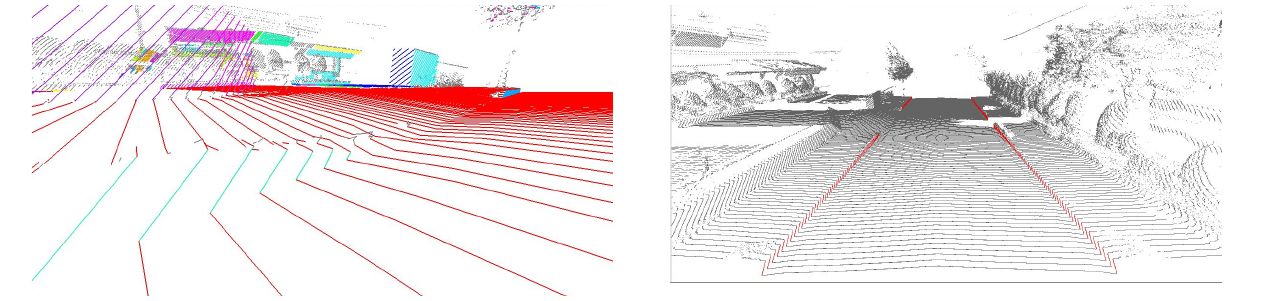
Figure 13: Manually extracted curb points for comparison.